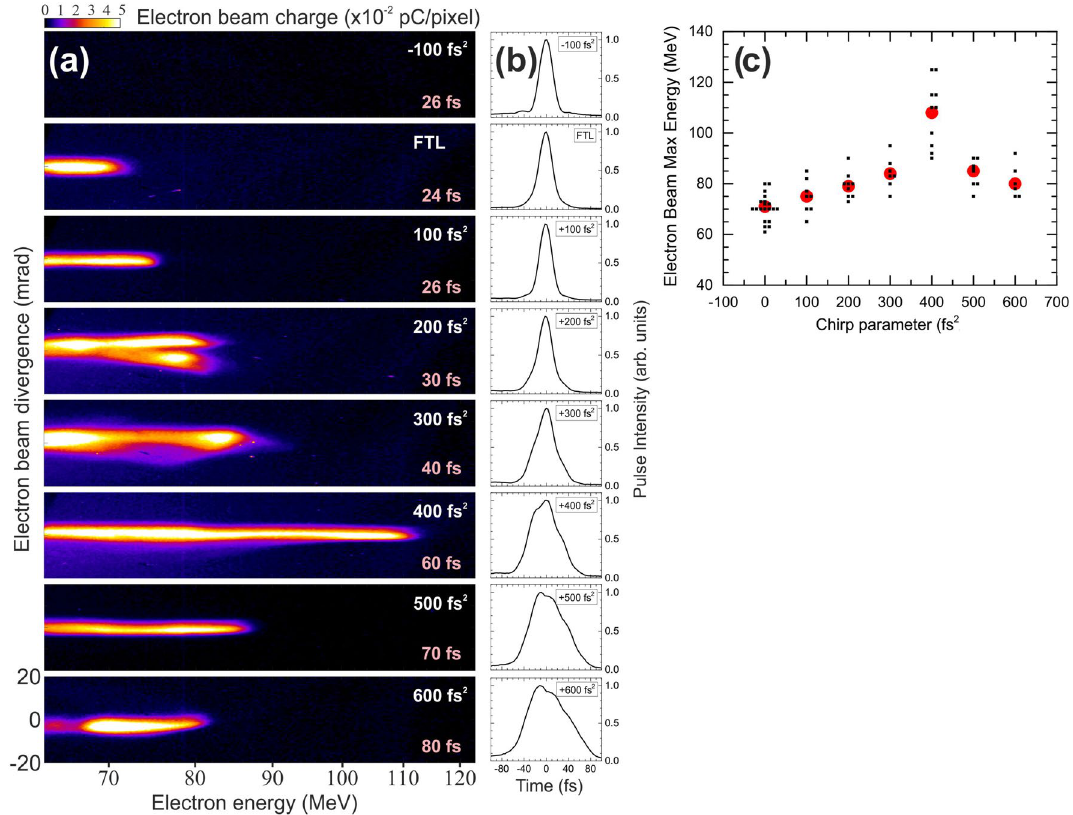
Figure 2. ( a ) Representative measurements of electron spectral images obtained by the interaction of 826 mJ chirped laser pulses with He gas-jet targets. The spectral images cover a kinetic energy range from 62 to 122 MeV, as allowed by the magnetic spectrometer geometry and scintillating screen dimensions. Note that electron spectra for negative chirp values showed no measurable electron signals, a fact that is attributed to their lower than 62 MeV kinetic energies. The spectral image for the − 100 fs 2 , shown at the top panel, is typical for all the negatively chirped laser pulses used in this study. ( b ) The corresponding to the measurements of ( a ) FTL and chirped laser pulses intensity temporal shapes. ( c ) Reproducibility measurements of the maximum electron energy (measured at 1/e) for FTL and chirped laser pulses. The black filled squares correspond to the individual measurements. Note that identical maximum energy values have been closely separated in the chirp axis for better visibility. Large red filled circles correspond to the averaged values for each